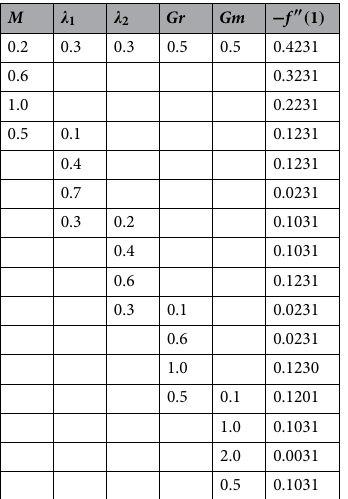
f ′′ ( 1 ) for M , (cid:31) 1 , (cid:31) 2 , Gr and Gm . −